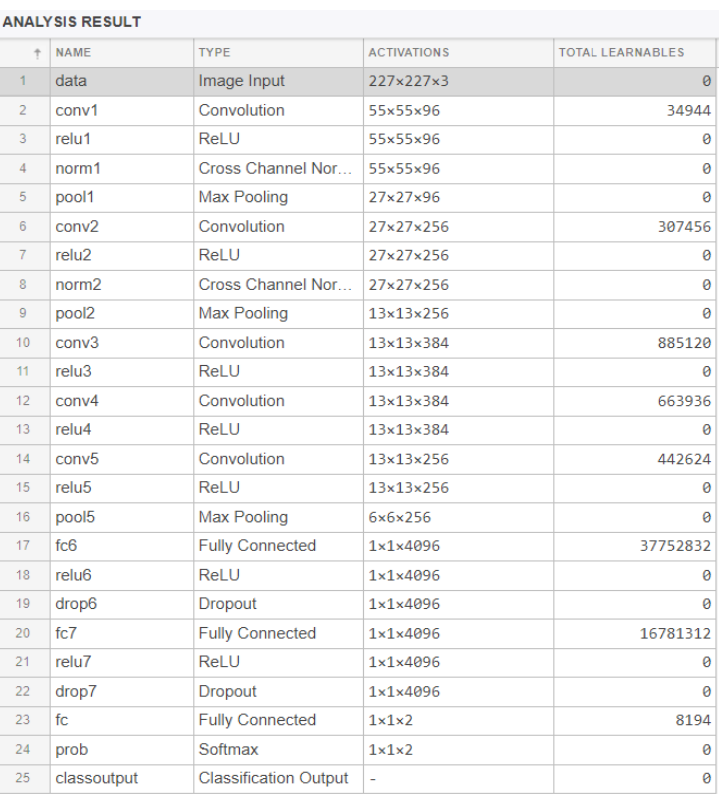
Figure 13. Layer-wise structure of Alexnet from MATLAB neural network toolbox.